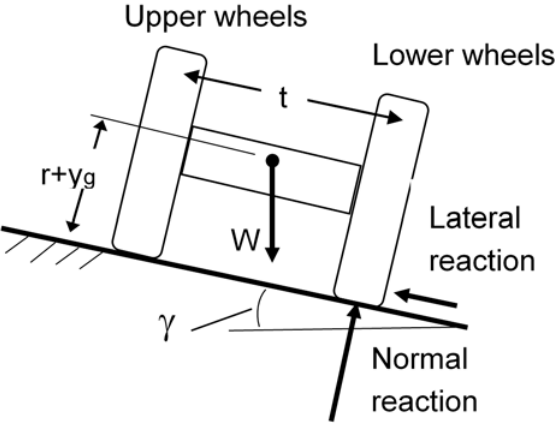
Figure A2. Vehicle being driven across a slope, angle γ .